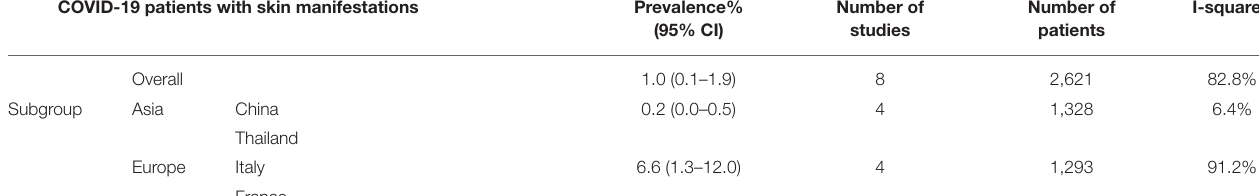
TABLE 3 | Frequency of skin manifestations among patients with COVID-19.